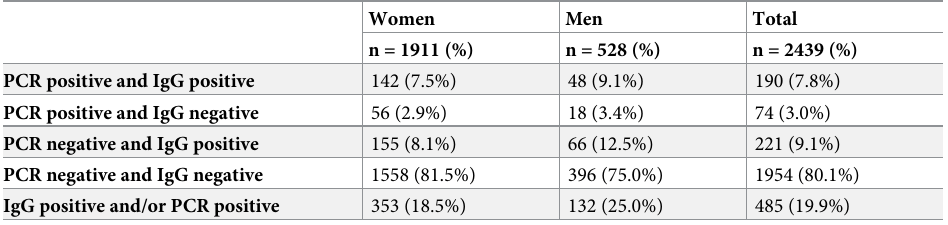
Table 2. Frequency of SARS-Cov-2 rRT-PCR and IgG result cases by sex.